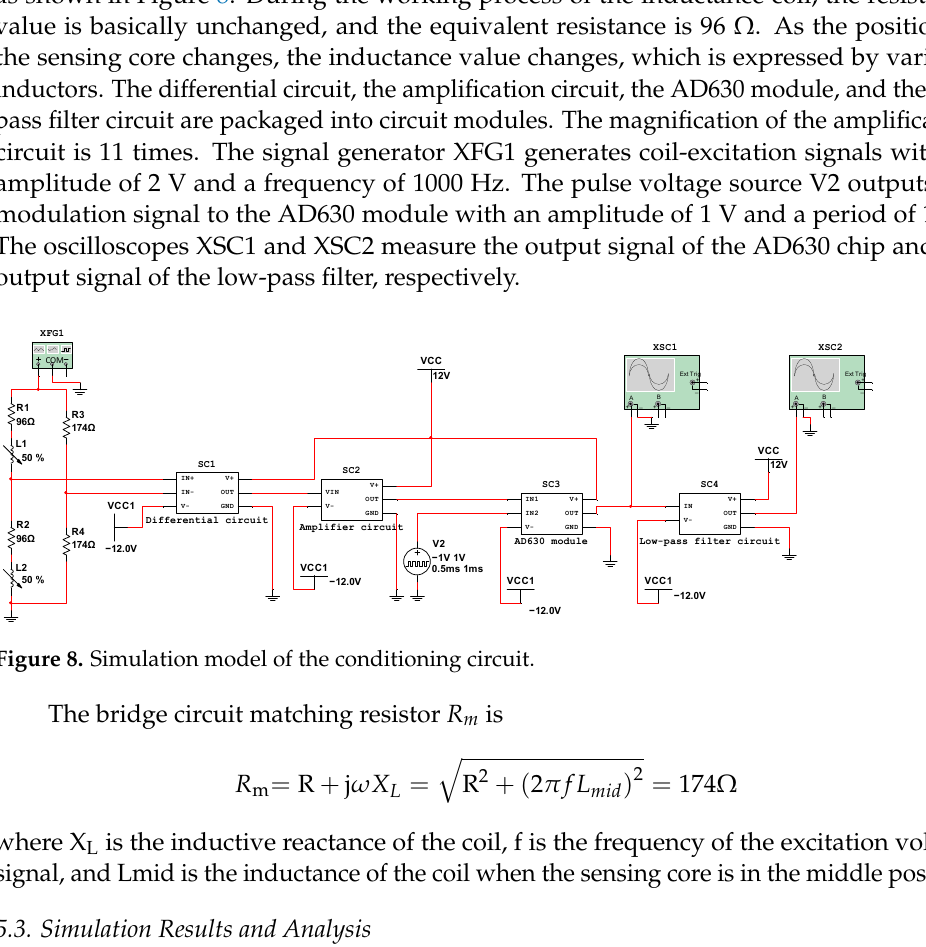
Figure 9. Output signal of the AD630 chip under three excitation signals. It can be seen from Figure 9 that the magnitude and direction of displacement can be tested by using the bridge circuit with three excitation signals. When the sensing core moves in the positive direction, the output voltage is negative; when the sensing core moves in the negative direction, the output voltage is positive. Under different excitation signals, the output signal of the AD630 chip is quite different in terms of amplitude change and phase shift. During the entire stroke of the transducer, the maximum output voltage of the sine signal is 4.98 V, the minimum output voltage is − 4.98 V, and the voltage range is 9.96 V.